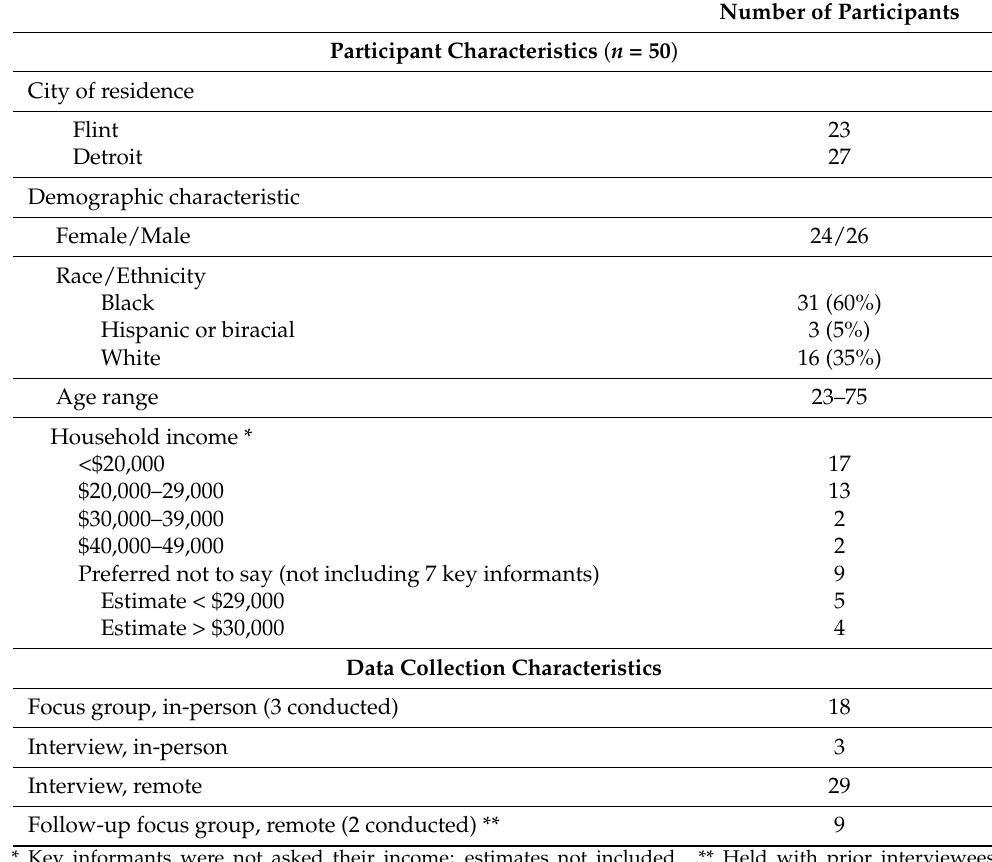
Table 1. Descriptive statistics of